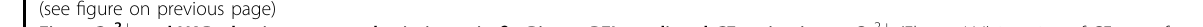
Fig. 4 Ca 2 + and YAP play important roles in integrin β 1-Piezo1 PFL-mediated CF activation. a Ca 2 + (Fluo-4 AM) imaging of CFs transfected with siRNA targeting Piezo1 (siPiezo1) or with negative control siRNA (siNT), showing reduction of mechanosensitive cytosolic Ca 2 + elevation after 3 days of culture in CFs with Piezo1 knocked down. Scale bar, 50 μ m. b Quanti fi cation of fl uorescence intensity data from panel a ( n ≥ 33 cells). c Immuno fl uorescence analysis indicated that nuclear YAP decreased following siPiezo1 inhibition of Piezo1 (blue, nucleus (DAPI); green, YAP; red, F- actin). Scale bar, 10 μ m. d Quanti fi cation of the YAP nuclear-to-cytoplasmic ratio from images represented by those in panel c ( n ≥ 12 cells). e RT-PCR analysis of downstream YAP genetic targets ( CYR61 and CTGF ) in CFs with or without Piezo1 knockdown by siPiezo1. f Immuno fl uorescence analysis revealed that α -SMA (green), a marker of CF differentiation, was attenuated by the Piezo1 blocker GsMTx4, but that mechanosensitive α -SMA expression could be rescued by transfecting CFs to produce excess YAP. Scale bar, 50 μ m. g RT-PCR analysis of α -SMA, Col 1, PDGFR- α and TGF- β 1 in YAP-overexpressing CFs in the presence of GsMTx4 indicates that CF activation in response to matrix stiffness is enhanced by Piezo1 and can be rescued by YAP overexpression. h Schematic diagram of signaling downstream of the